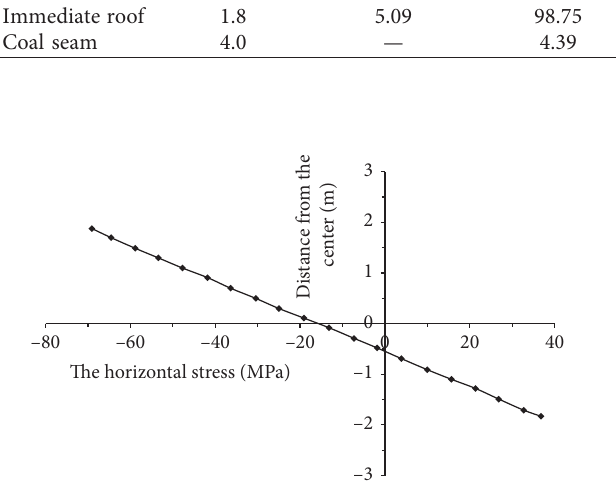
Figure 14: Horizontal stress in the middle of 1905S air-return entry.